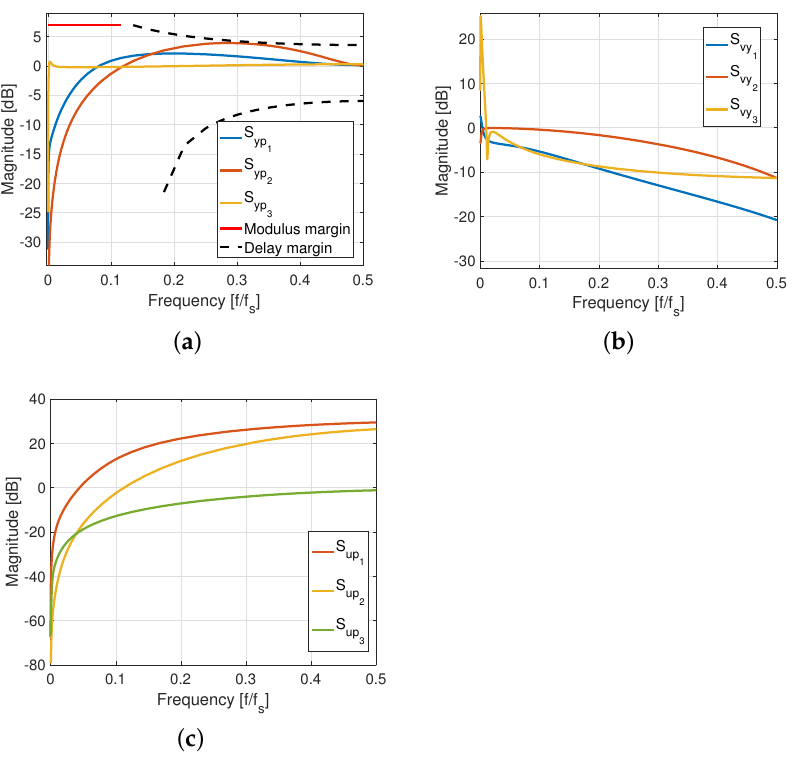
Figure 7. Sensitivity functions for serial process. ( a ) Output sensitivity functions S yp ; ( b ) Input disturbance–output sensitivity functions S vy ; ( c ) Input sensitivity functions S up